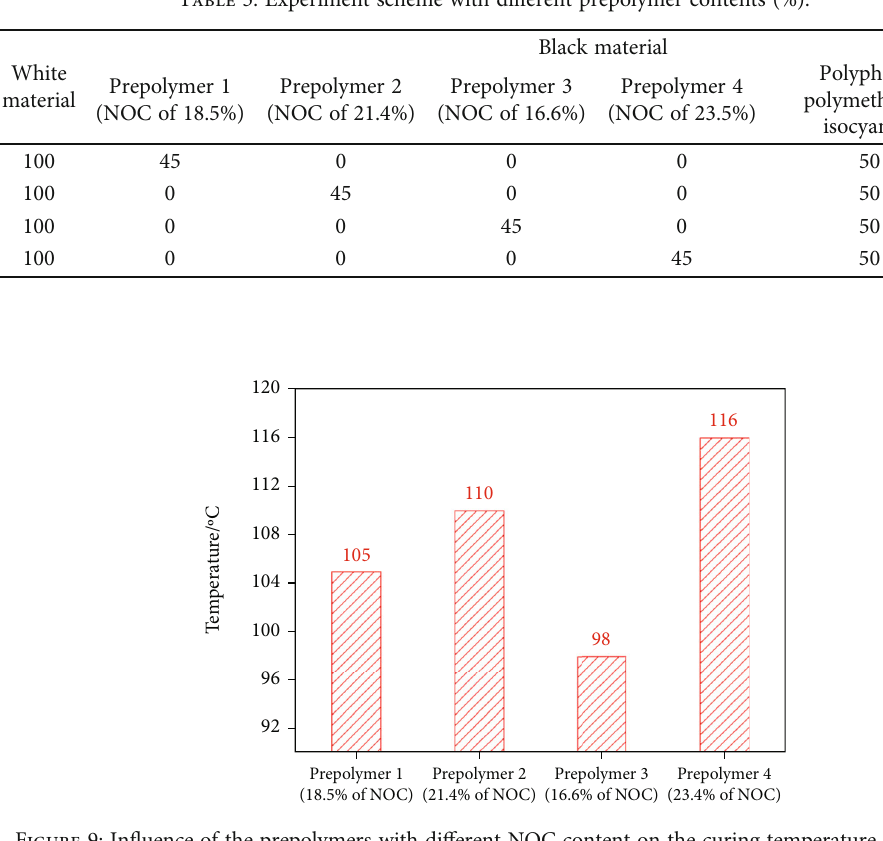
Table 5: Experiment scheme with di ff erent prepolymer contents (%).